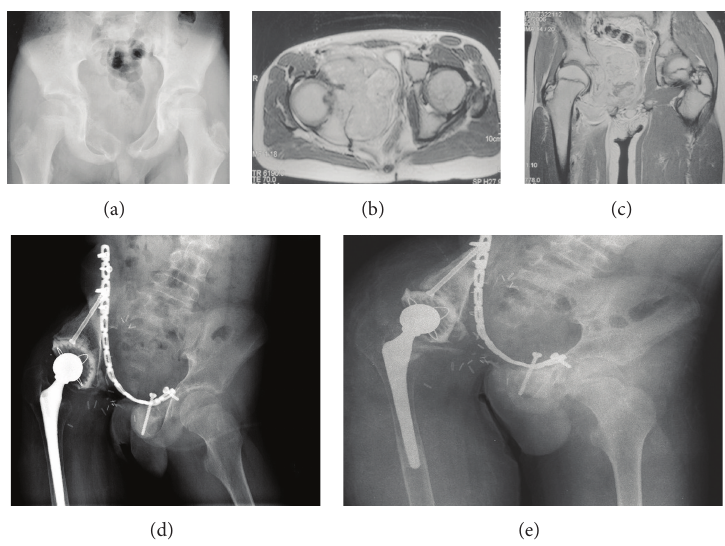
Figure 1: A twelve-year-old male with a diagnosis of Ewing sarcoma in the pelvic region (a). Axial (b) and coronal (c) magnetic resonance images at diagnosis. Type II-III internal hemipelvectomy and reconstruction with alloprosthetic composite were performed (d). After 62 months, severe allograft resorption and purulent drainage were detected in the surgical site (e). External hemipelvectomy was performed for the recalcitrant infection. The patient was dead because of sepsis in the 71st